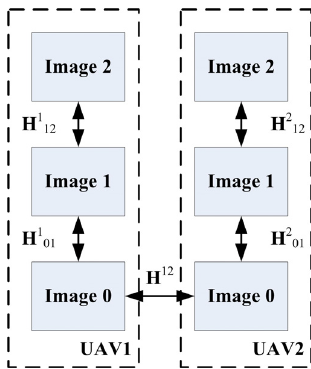
Figure 5. Scheme of relations between homographies.